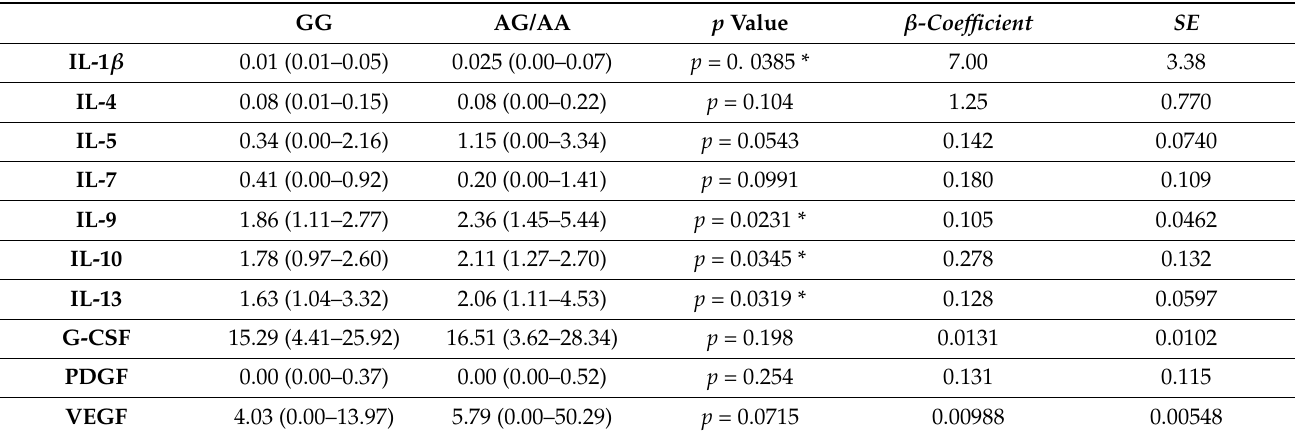
Table Legend: Subjects carrying the homozygous major allele of SNP (GG), subjects carrying A minor allele (AG/AA) for SNP rs18188792 . (*) denotes statistical significance ( p < 0.05) using logistic regression analysis. Ab- breviations: interquartile range (IQR); standard error (SE); IL (interleukin); G-CSF (granulocyte colony stimulating factor); PDGF (platelet-derived growth factor); VEGF (vascular endothelial growth factor). CSF analysis missing data: GG group (3 patients, 3.4%), AG/AA group (7 patients, 8.4%).